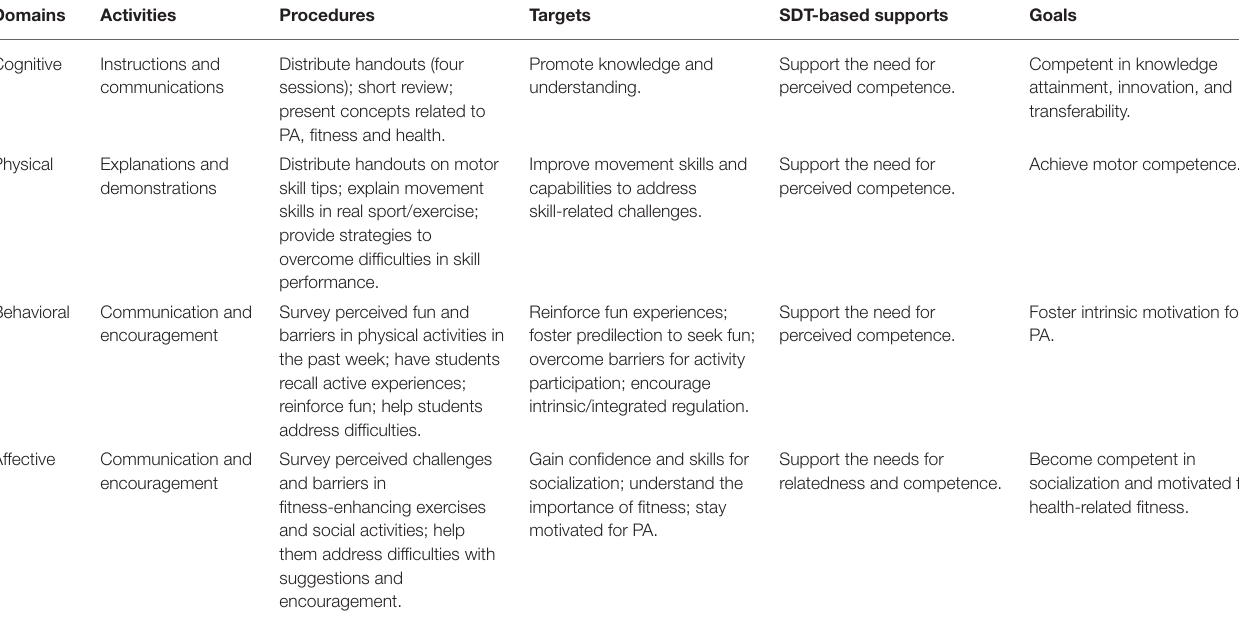
TABLE 2 | Overview of the SDT-based workshop.